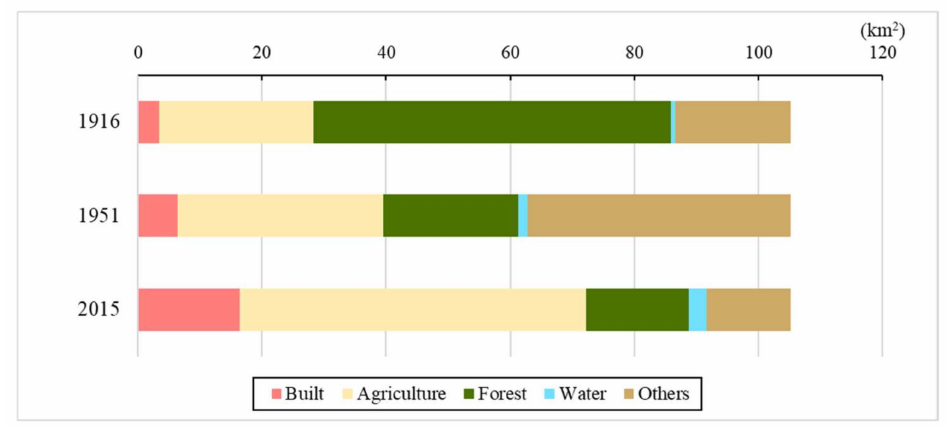
Figure 4. Land area by category in 1916, 1951, and